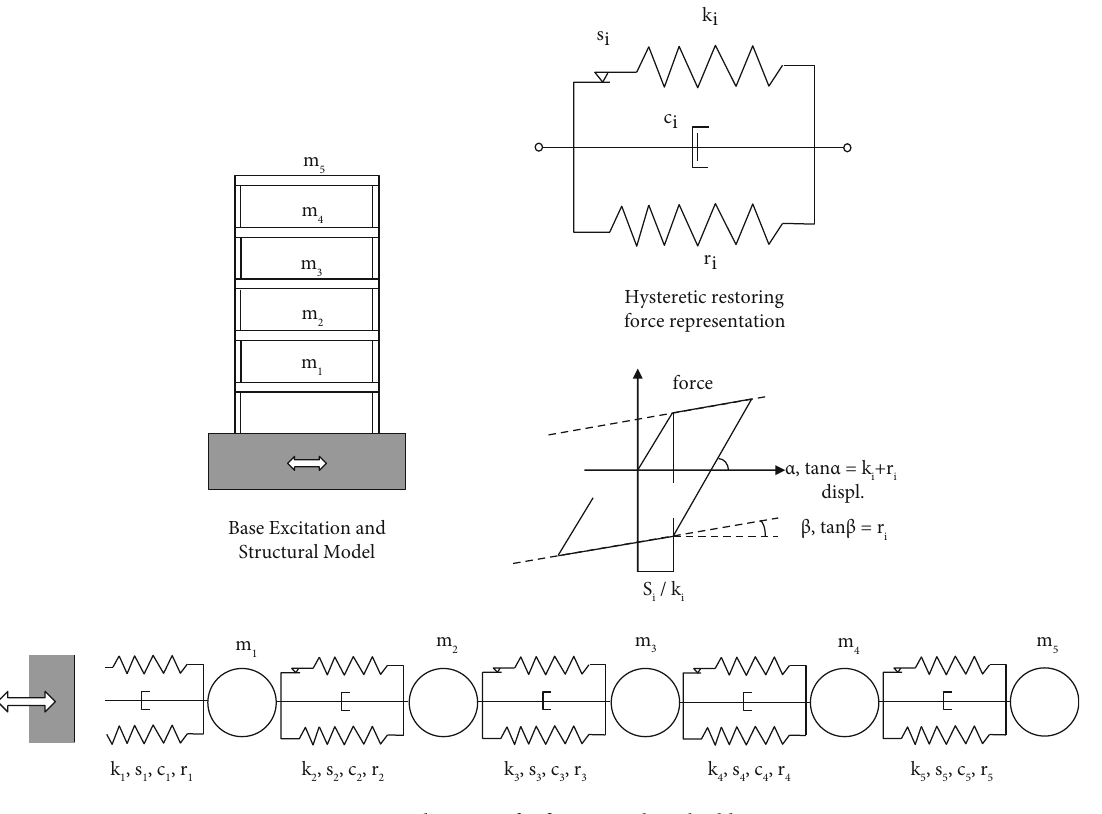
Figure 6: Schematic of a fi ve-story shear building.